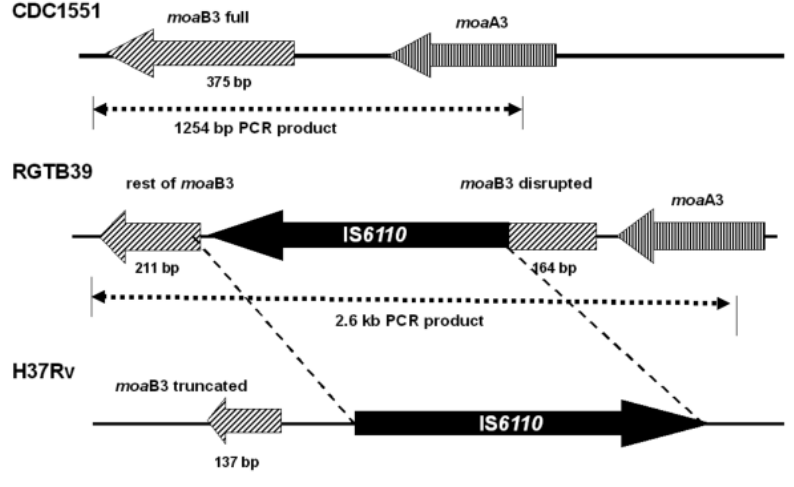
Figure 3. Schematic representation of the comparison of RvD5 and the flanking regions in H37Rv, CDC1551 and RGTB39. In CDC1551 the moa B3 gene is intact. In RGTB39 it is disrupted after 211 bp. In H37Rv, the gene is truncated with only a 137 bp fragment in the genome. The region spanning the expected PCR product of 1254 bp in CDC1551 and the region spanning the 2.6 kb PCR product in RGTB39 are shown in dotted